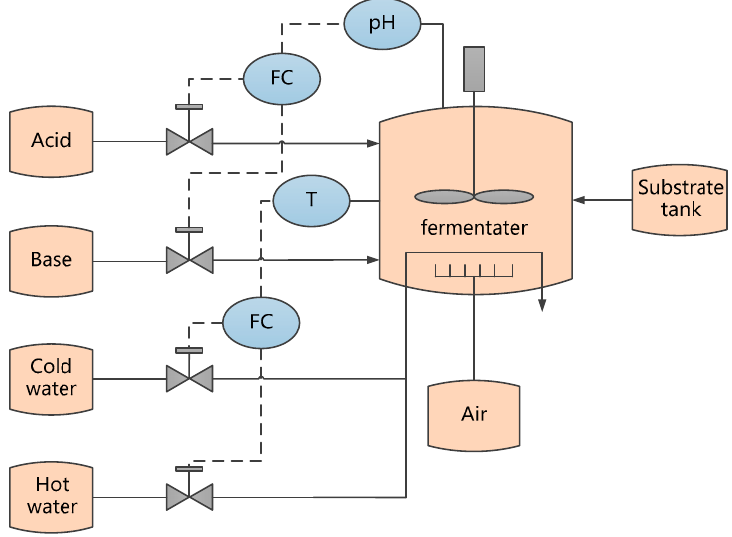
Figure 7. Flow diagram of penicillin fermentation process.